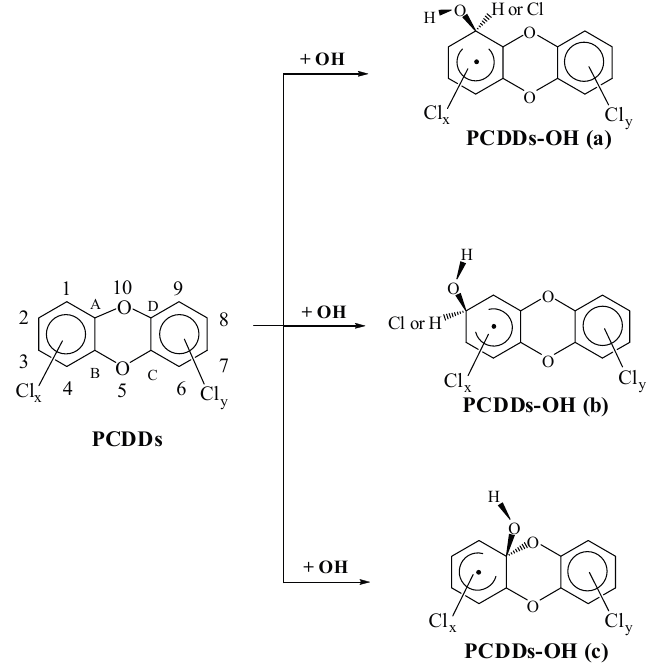
Figure 1. Schematic pathways for OH radical addition of